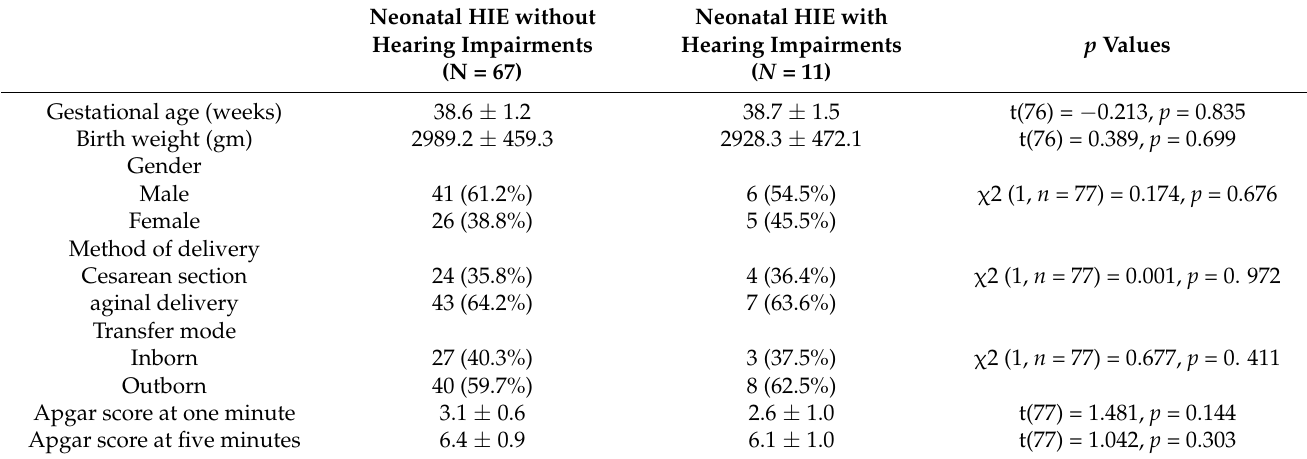
Table 1. Demographic data of 78 newborns with neonatal hypoxic–ischemic encephalopathy (HIE) with and without hearing impairment (HI).